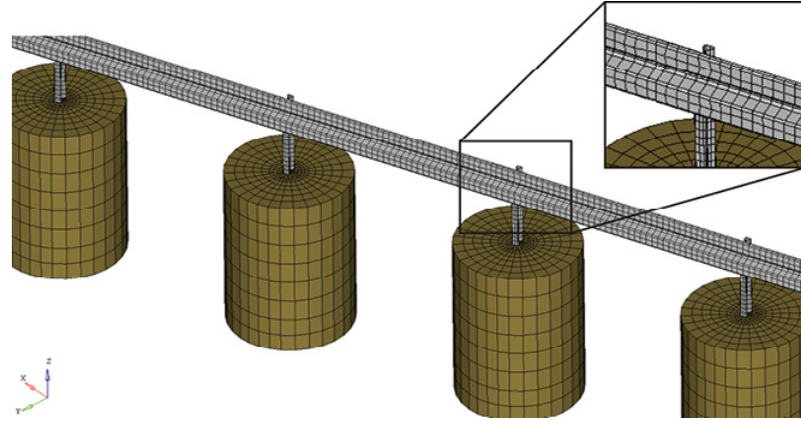
Figure 12. Fragment of analysed road barrier with type B guide